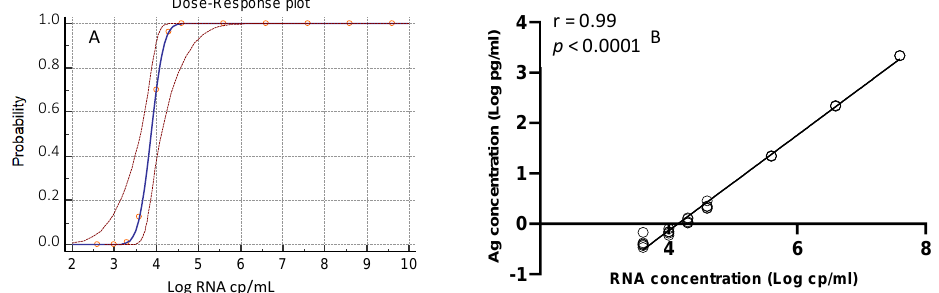
Figure 1. ( A ) Probit regression curve (blue line) with 95% of Confidence Interval (dashed red line). ( B ) Correlation between the antigen concentration (Log pg/mL) and SARS-CoV-2 RNA (Log copies/mL).